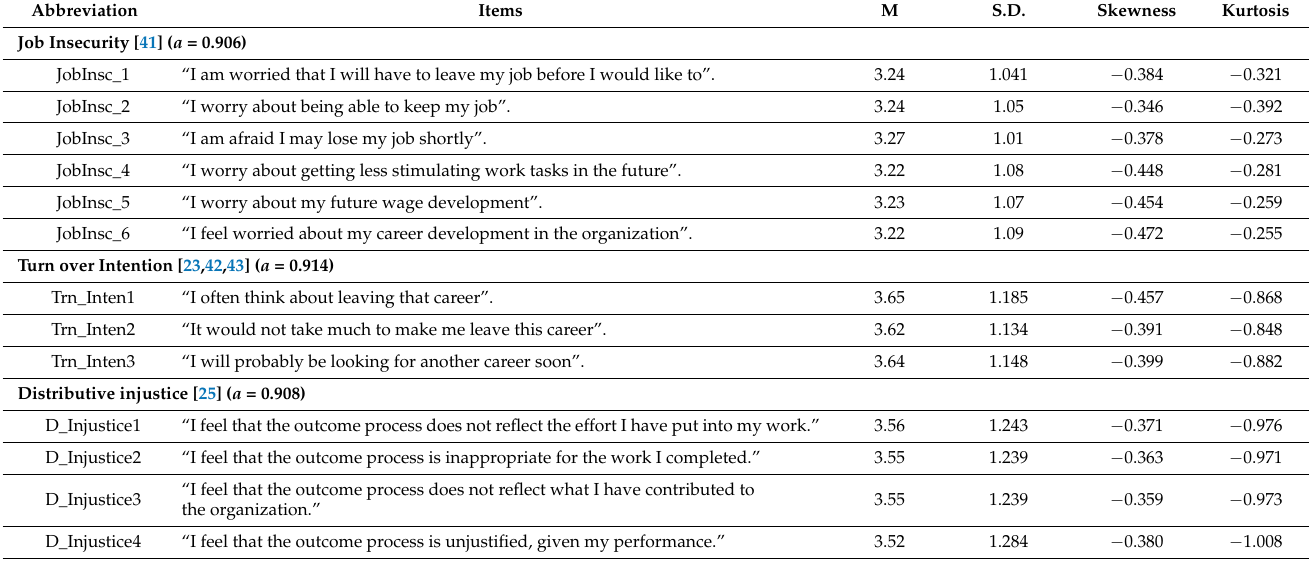
Table 2. Descriptive data (Mean, Standard Deviation, Skewness and Kurtoses